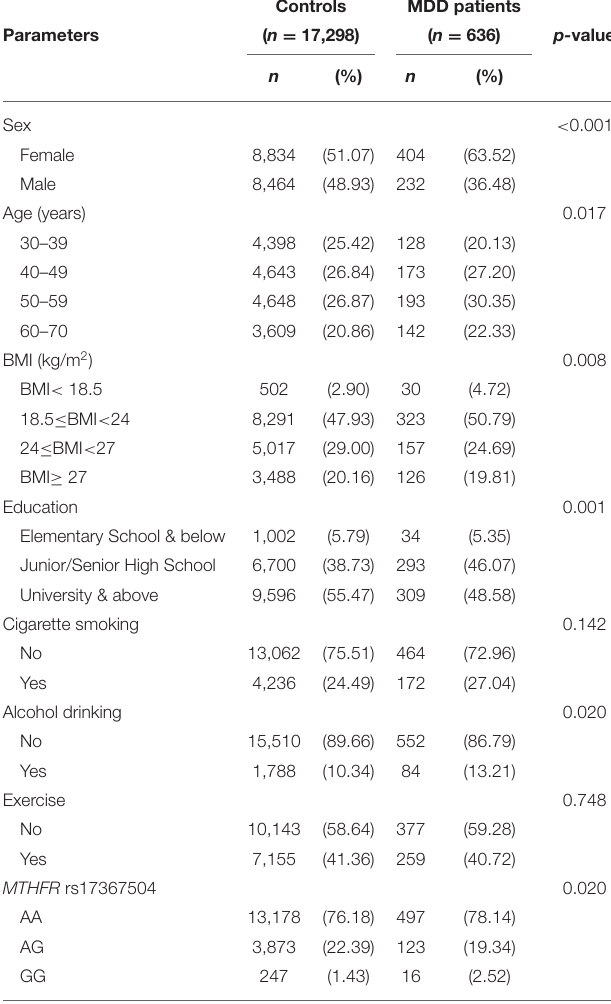
TABLE 1 | Characteristics of patients and